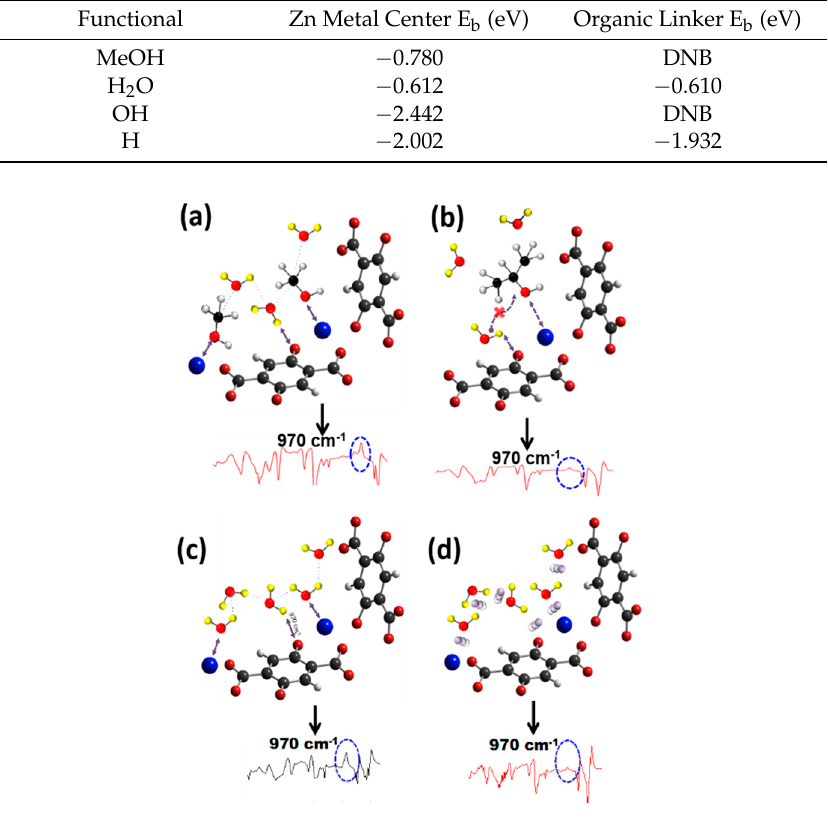
Figure 3. Schematic of Zn-MOF-74 interacting with ( a ) methanol/D 2 O assisting the reaction by the formation of clusters in a similar fashion as pure D 2 O; ( b ) isopropanol/D 2 O hindering the interaction of D 2 O with the secondary carbon in the IPA molecule due to the steric barrier; ( c ) pure deuterated water (D 2 O) and cluster formation; and ( d ) He/D 2 O, with He obstructing water cluster formation. White, yellow, red black, blue and purple spheres represent H, D, O, C, Zn, and He atoms. Each schematic has a normalized Zn-MOF-74 IR spectra after 8 h of reaction at 180 °C.